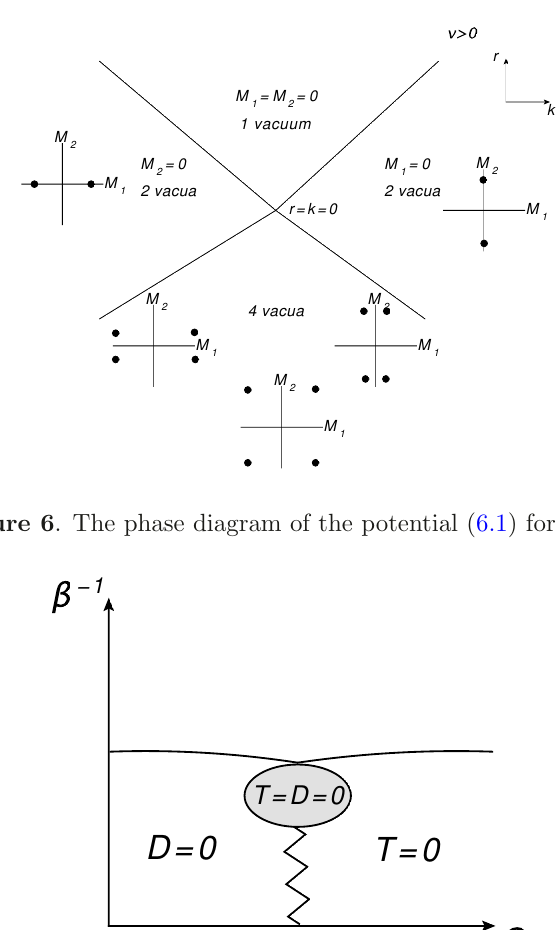
Figure 5 . The phase diagram of the potential (6.1) for ν < 0. The zigzag line corresponds to a first-order transition.